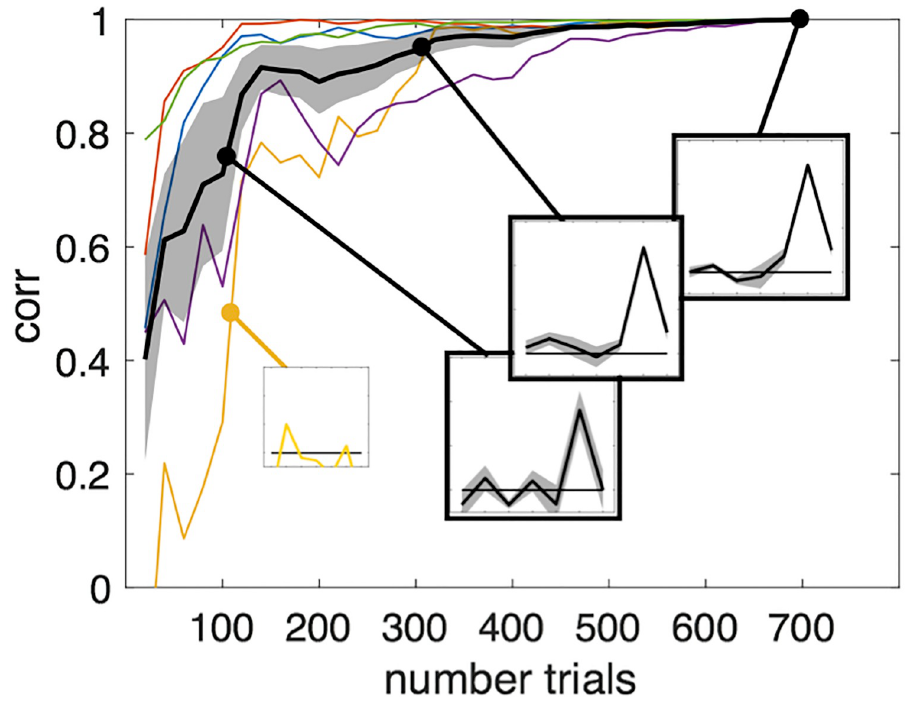
Fig 6. Correlation between the kernel derived using the n first trials of case-study 1, and the kernel derived using all trials ( n = 700); n varying by steps of 20 trials (individual curves: Thin colored lines; averaged ± sem: Thick black line with shaded error bars). These curves reflect the “speed” at which our measure converges toward the final kernel estimate (insets show temporary kernels at stages n = 100, n = 300 and n = 700, averaged across subjects in black line, and for the subject with the slowest convergence in